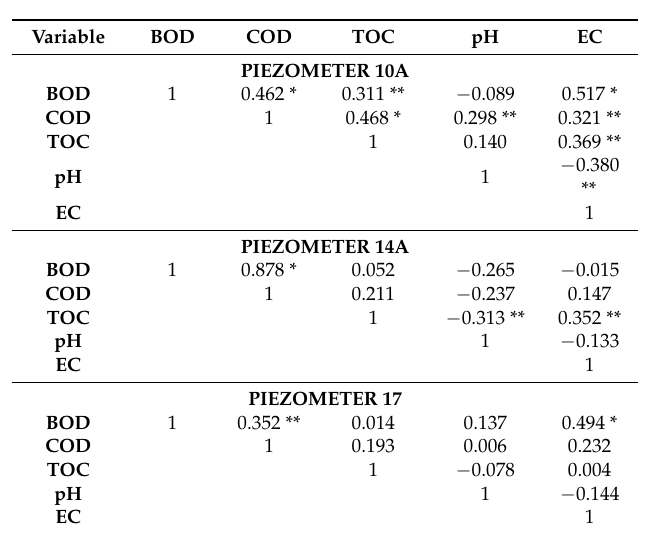
Table 6. Pearson’s correlation analysis between selected pollution indicators based on monitoring data from piezometers located in the area of the adjacent